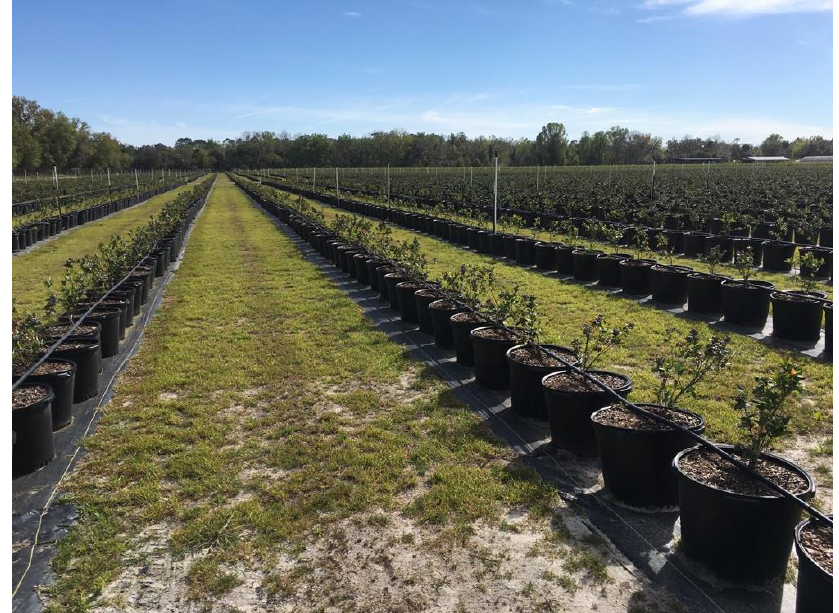
Figure 2. Southern highbush blueberry containerized soilless substrate production with 5434 plants per hectare in south Florida.